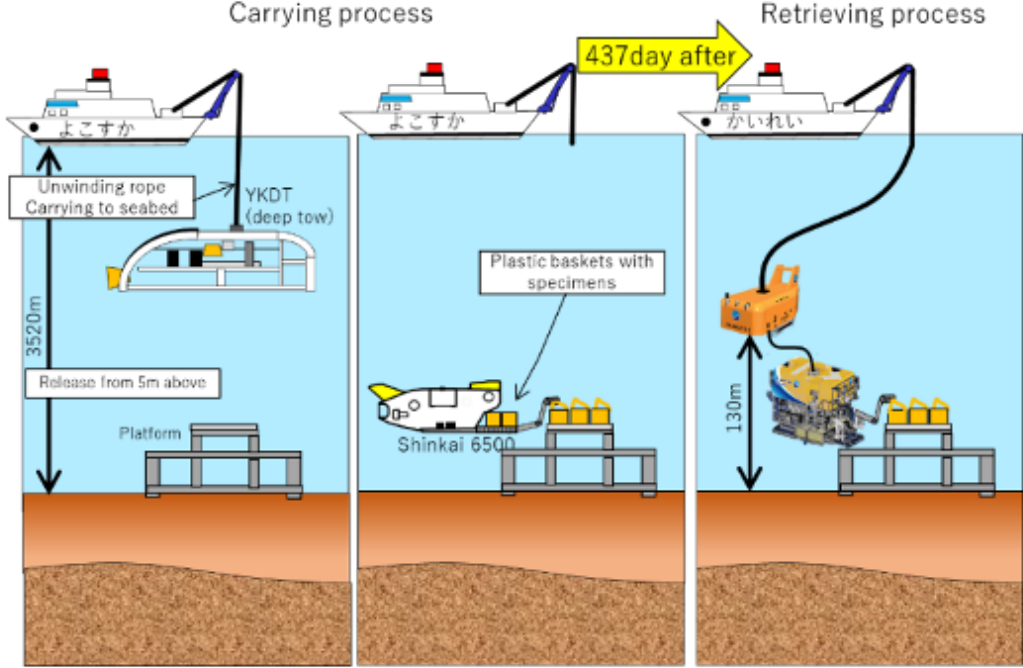
Figure 5. Overview of placement and retrieval processes in 2018 and